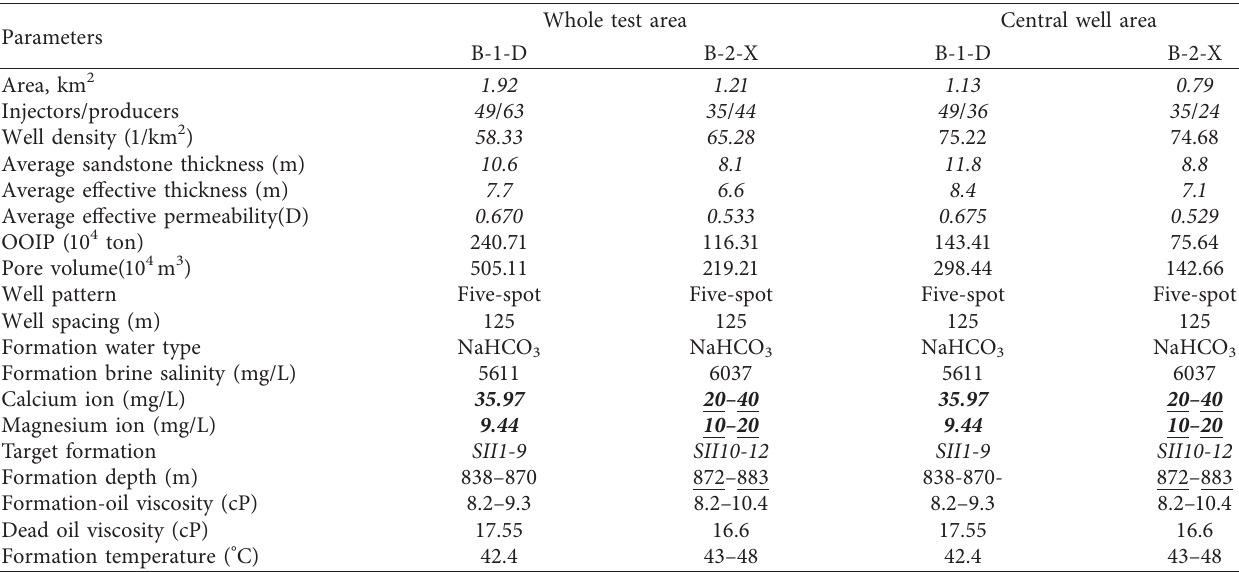
Figure 2: ASP flooding production share in Daqing Oilfield [40]. Table 1: Comparison of basic reservoir physical